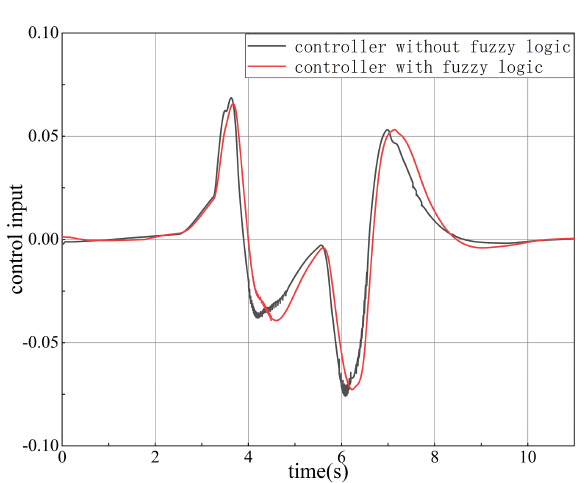
Figure 7. Output membership function.